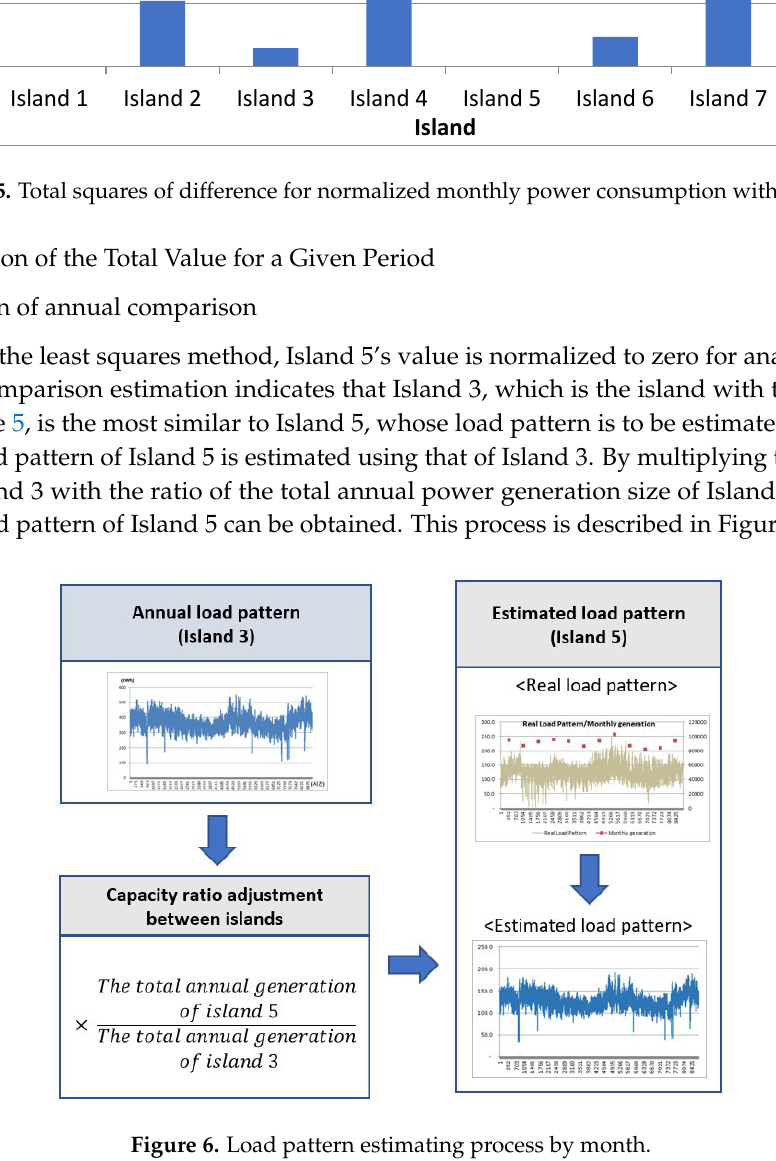
Figure 6. Load pattern estimating process by month.